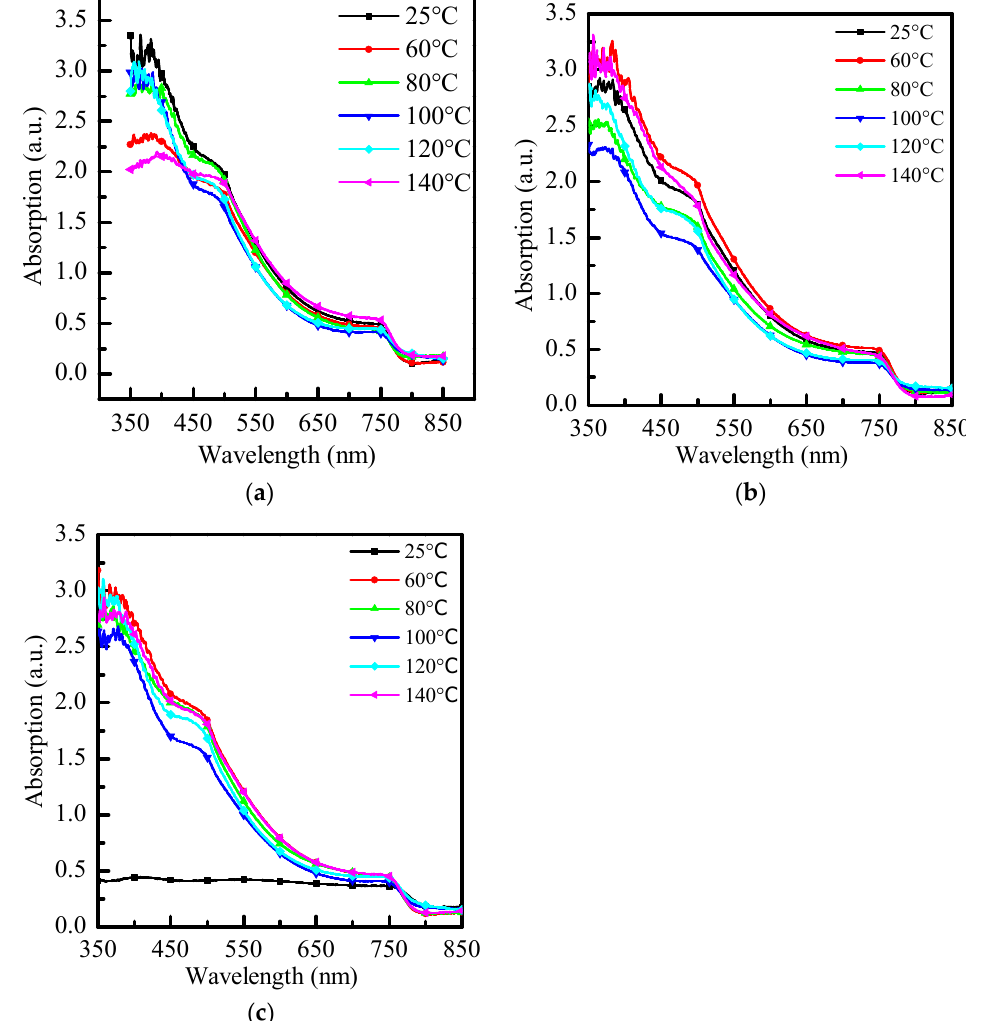
Figure 2. Absorption spectra of ( a ) toluene (PhMe), ( b ) chlorobenzene (PhCl), and ( c ) o -dichlorobenzene (ODCB) at different annealing temperatures, respectively.